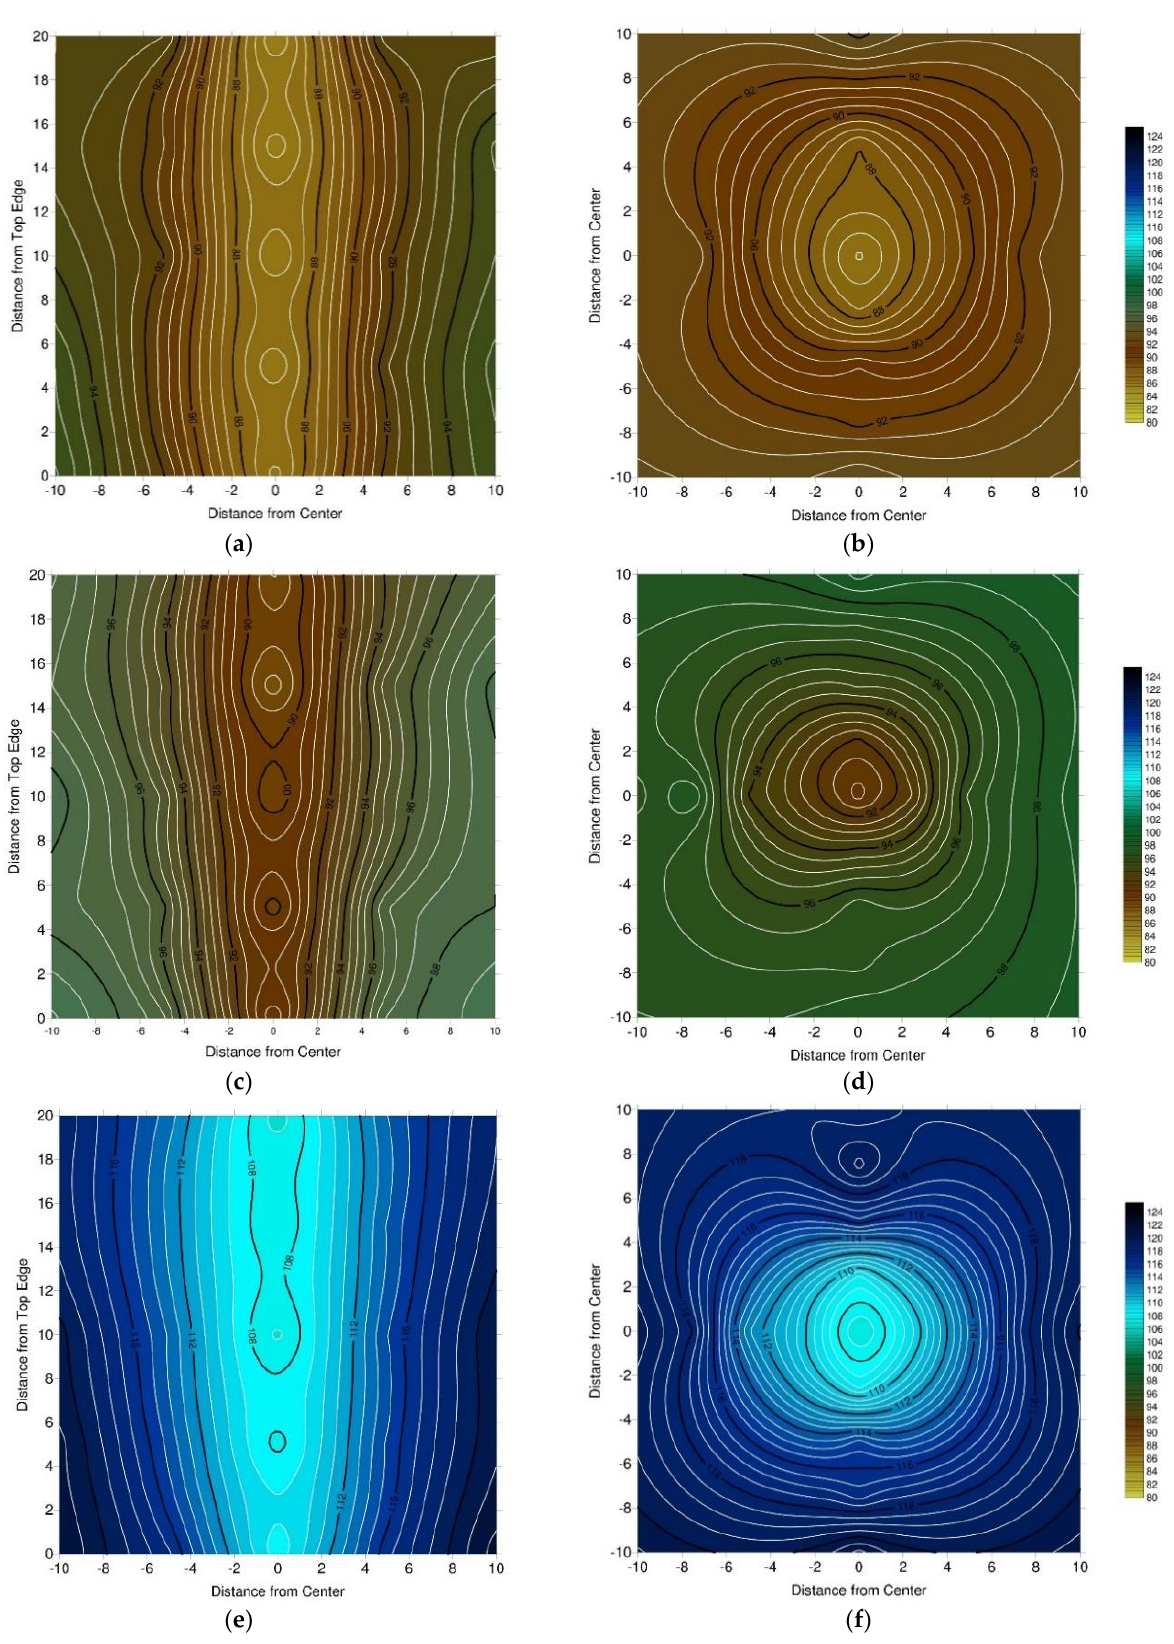
Figure 16. Color-coded contour maps for the hardness values recorded on the ( a , c , e ) LS and ( b , d , f ) TS of the AA2011 billets processed via ECAP processing after ( a , b ) 1- p , ( c , d ) 2-Bc, and ( e , f ) 4-Bc at 150 °C.